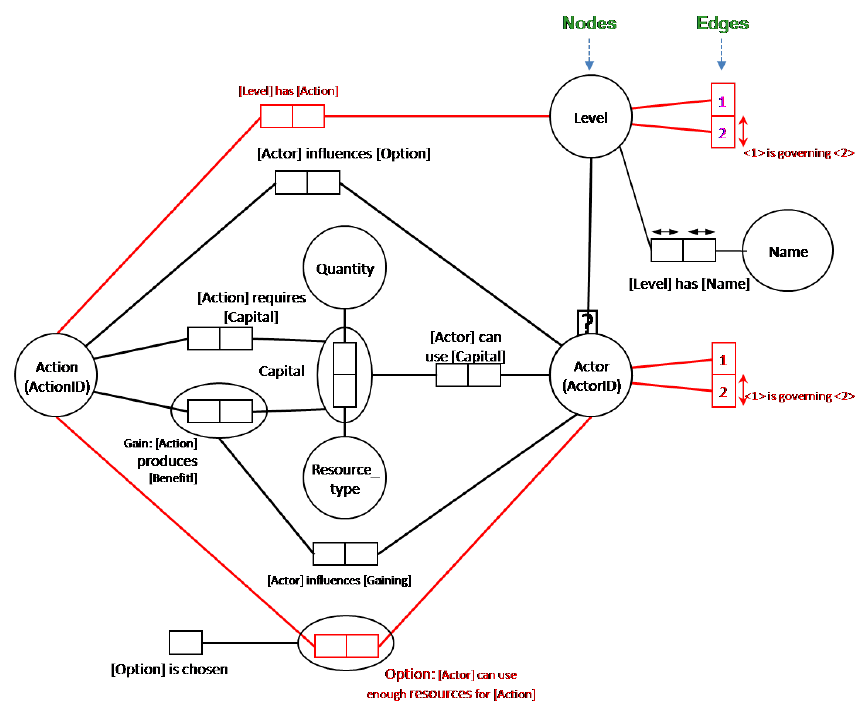
Figure 4. The AiC Conceptual